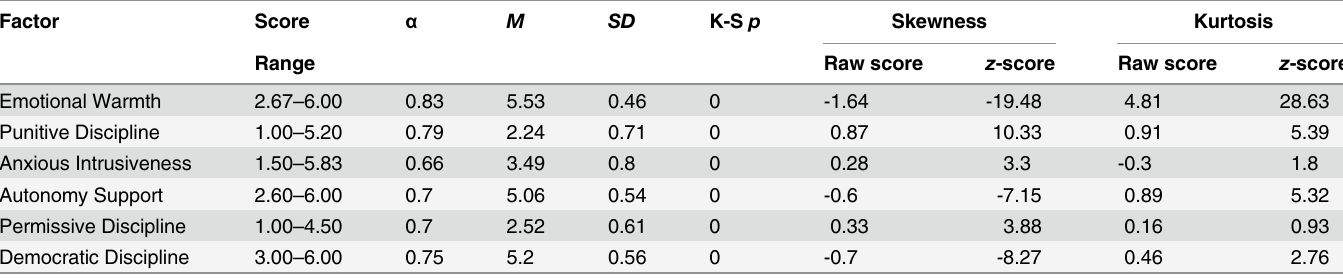
Table 5. Sample Descriptive Statistics for Final Solution (N = 846).